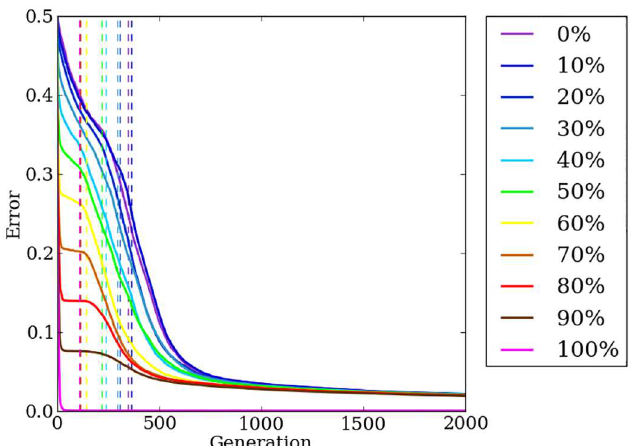
Fig 6. The mean error of Auto-Switch-HybrID generation champions over 2,000 generations on the target weights experiment. The line colors indicatethe regularityof the problemtested. Dashedvertical lines indicate the mean switch point per